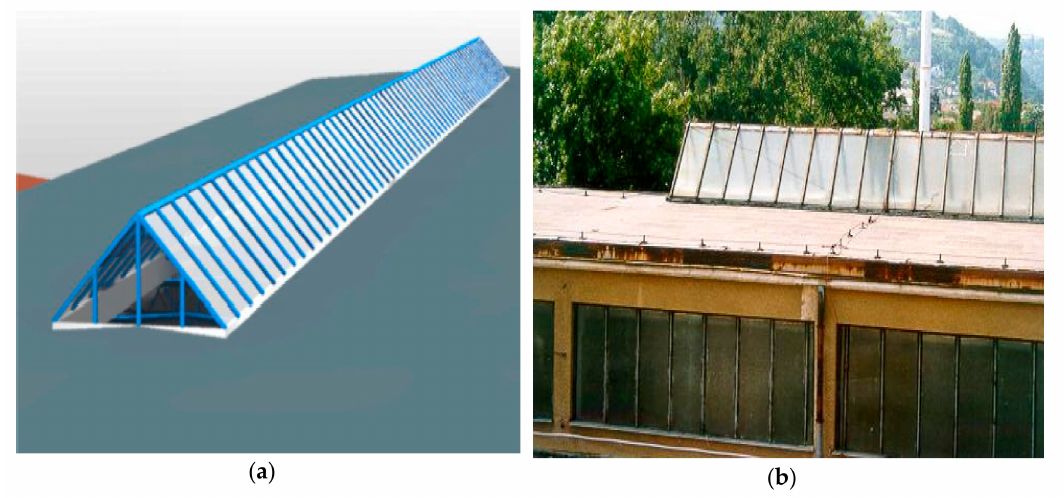
Figure 3. External view of the building: ( a ) model of the skylight; ( b ) view of the skylight.